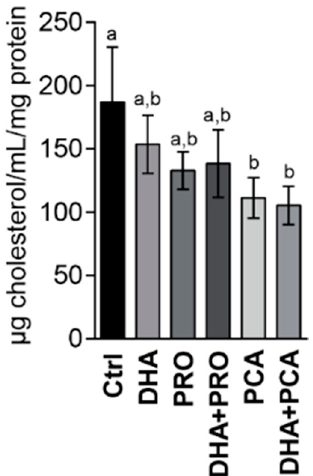
Figure 5. Cholesterol concentration in the media of control and supplemented cells after 24 h supplementation. Data are expressed as µg cholesterol/mL medium/mg protein in the well. Statistical analysis was carried out by the one-way ANOVA followed by Tukey’s HSD test. Different letters indicate statistical significance ( p < 0.05).